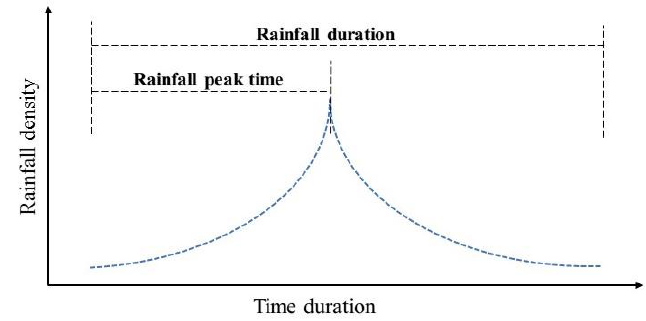
Figure 5. Designated rainfall hyetograph by using the Chicago hyetograph method.